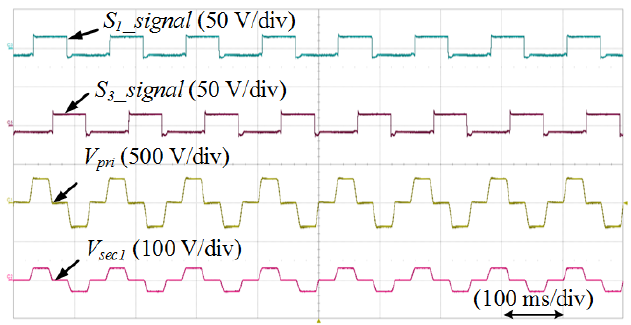
Figure 14. Experimental results about operation principle of the PSFB-CT converter.